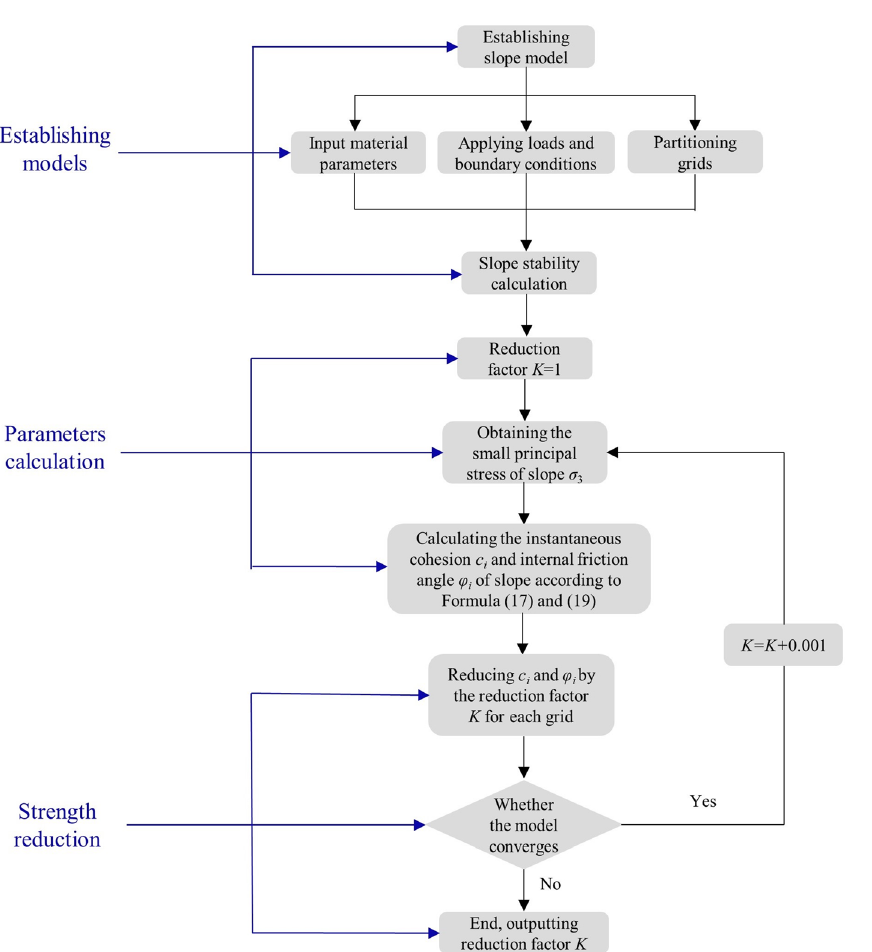
Figure 5. Flow chart for calculation of strength reduction